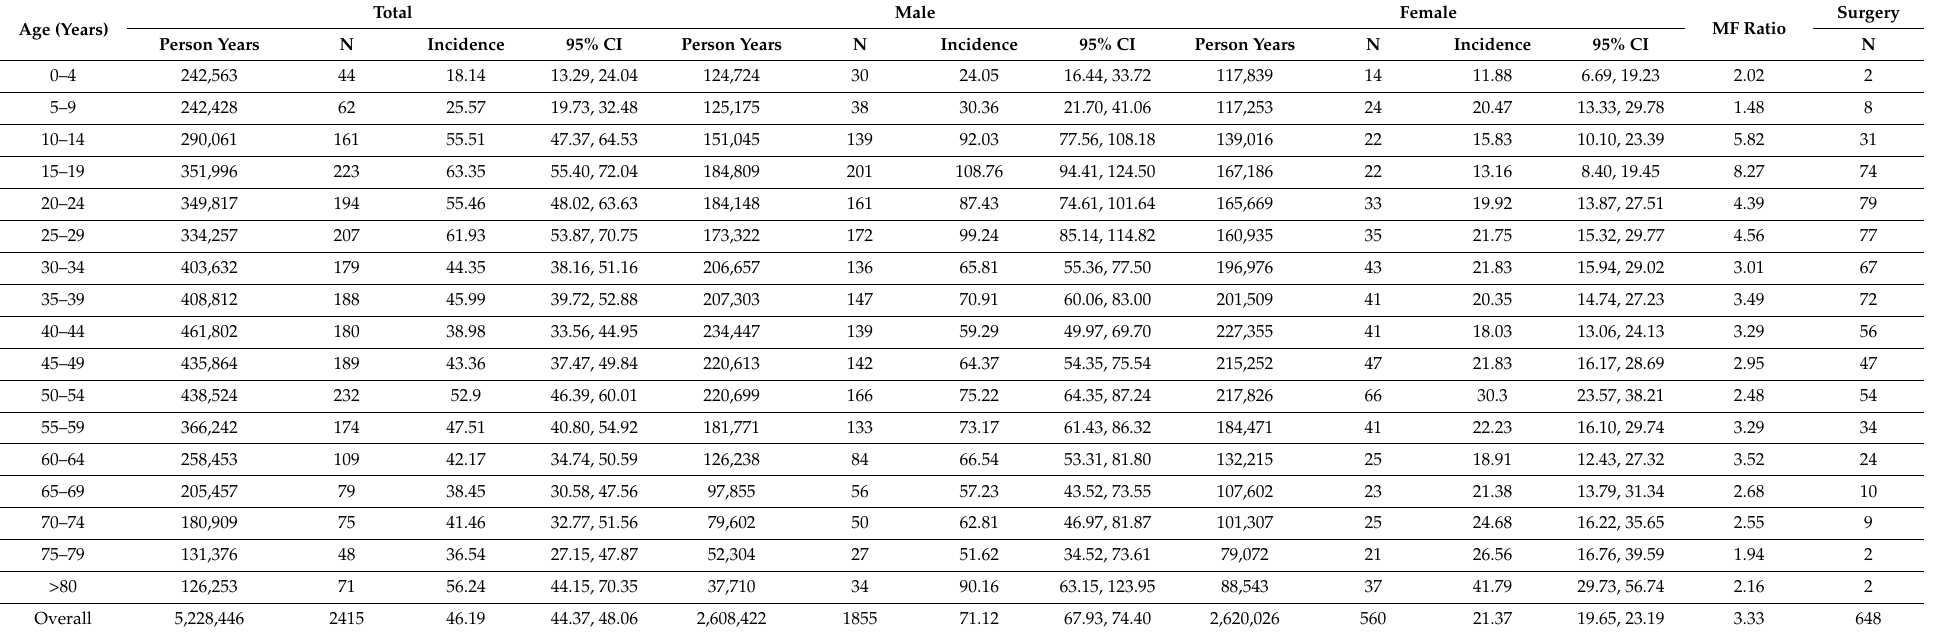
Table 1. Number of patients with incident orbital wall fractures and estimated incidence rate (per 100,000 person years) of orbital wall fractures in South